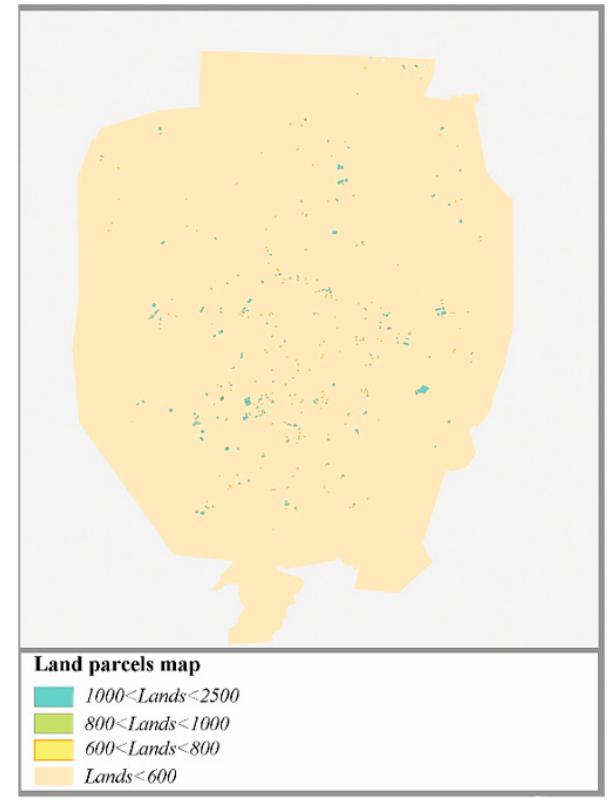
Figure 10. The land parcels map of Hamedan based on the sub-criteria measures in Table 1.